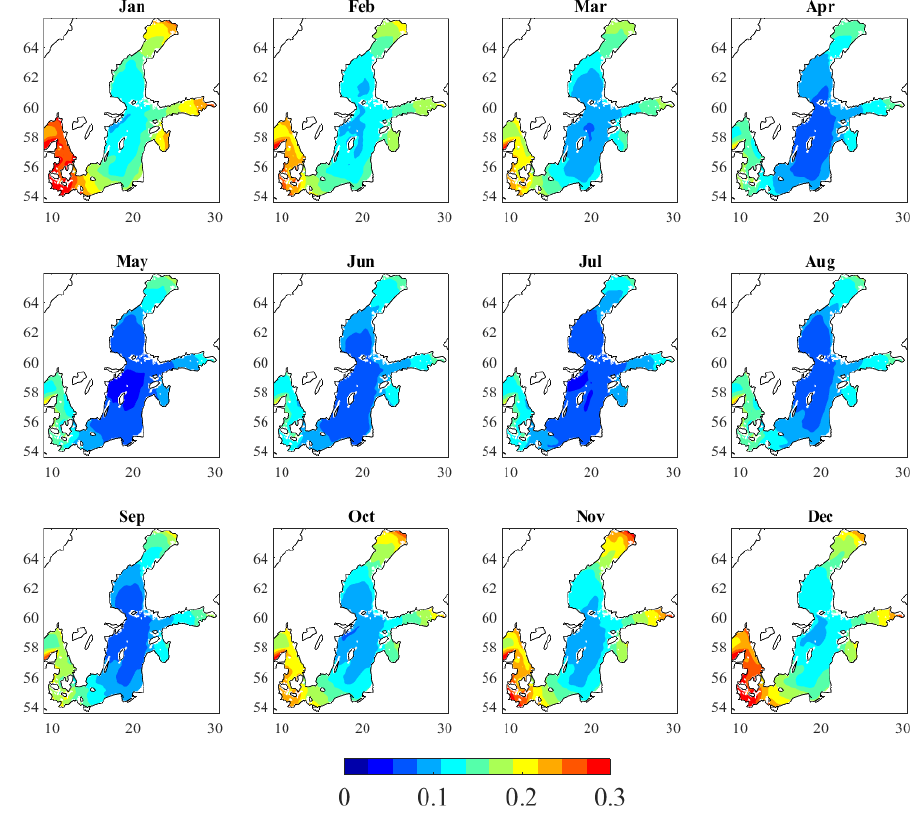
Figure 6. SD m, 10y – monthly SD (m) for each month over 10 years (2007–2016) of reanalysis data.